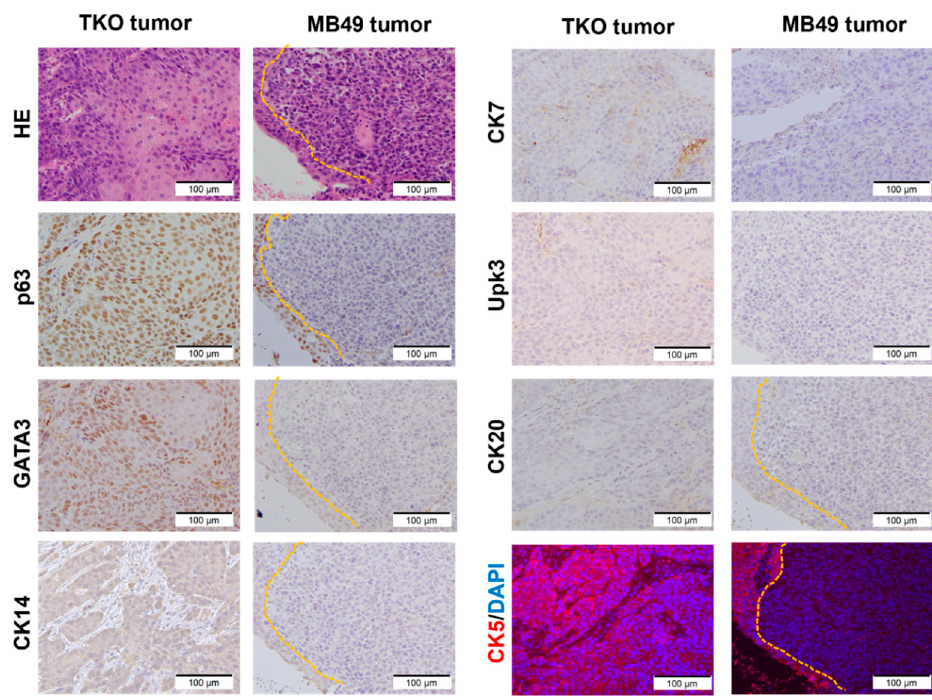
Figure 2. The expression of urothelial markers in TKO intravesical tumors. Sections from the TKO and MB49 intravesical tumors were stained by IHC and IHC-IF with urothelial lineage markers. The TKO tumors are positive for p63, GATA3, CK14 (weak), CK5, and CK7 (patchy), whereas the M49 tumors are negative for urothelial lineage markers. Note the strong positive stain of p63 and CK5 in the normal urothelium adjacent to the MB49 tumors (yellow dash line).